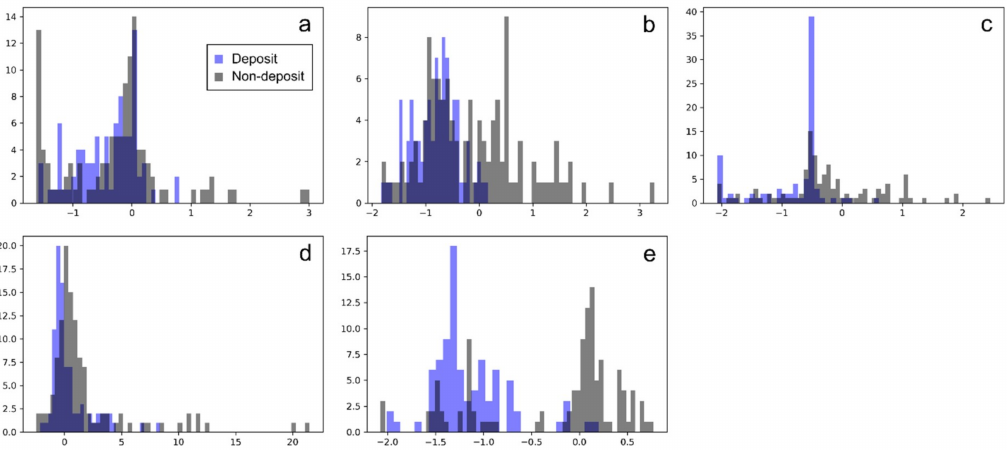
Figure A2. Histograms of ( a ) U, ( b ) Th, ( c ) K, ( d ) gravity and ( e ) magnetic anomaly data taken from the training set (deposit and non-deposit vectors). Data are normalized by standard deviation (x-axis). A noticeable dissimilarity is indicated by K and the magnetic records while there exist overlaps of data distributions for U and Th data. Histograms of training data attributes for different grid resolutions.